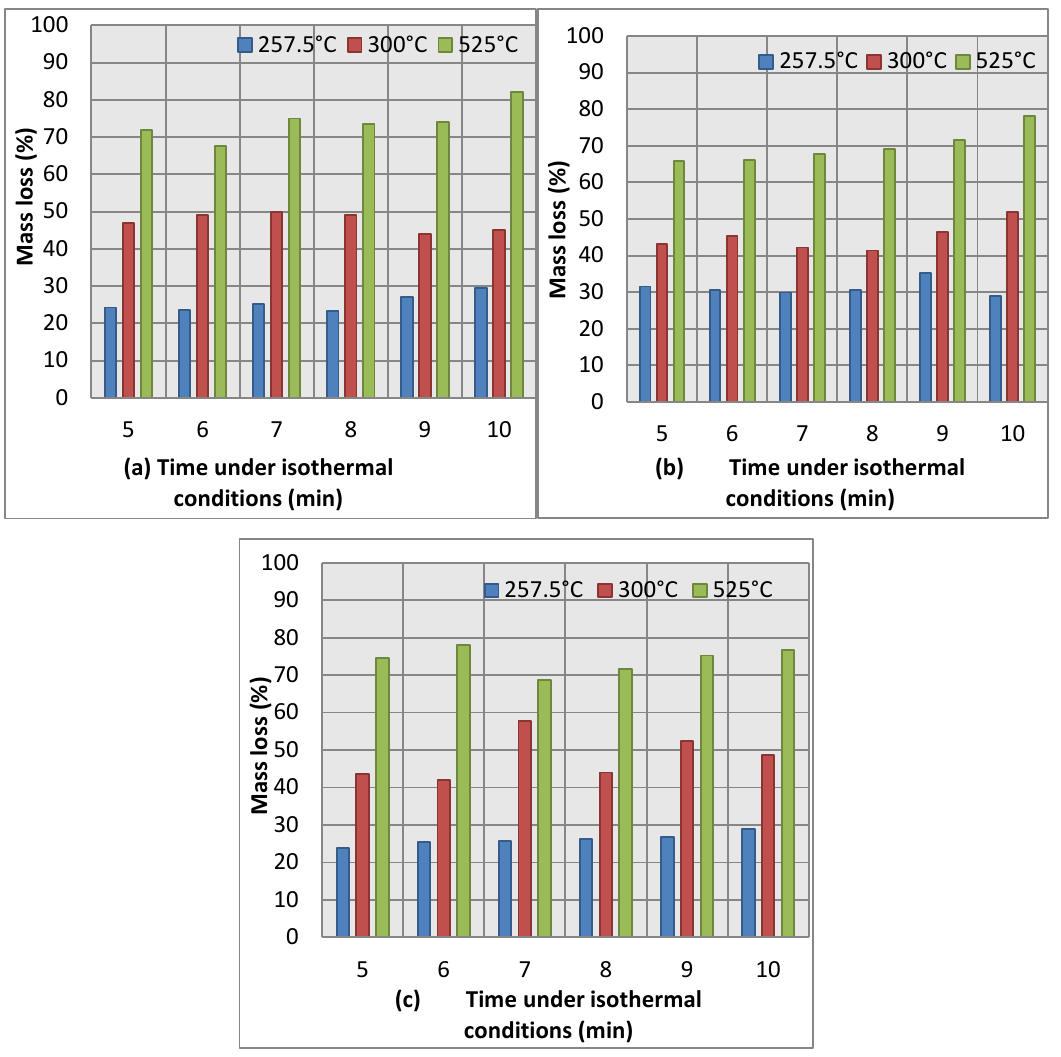
Figure 15. Maize straw torrefaction process TGA analysis results and process conditions as in temperature and optimal mass loss for production of biofuel, additive for natural fertilizers, activated carbon (Figure 15 a heating rate 5 K / min, Figure 15 b 10 K / min, Figure 15 c 20 K /